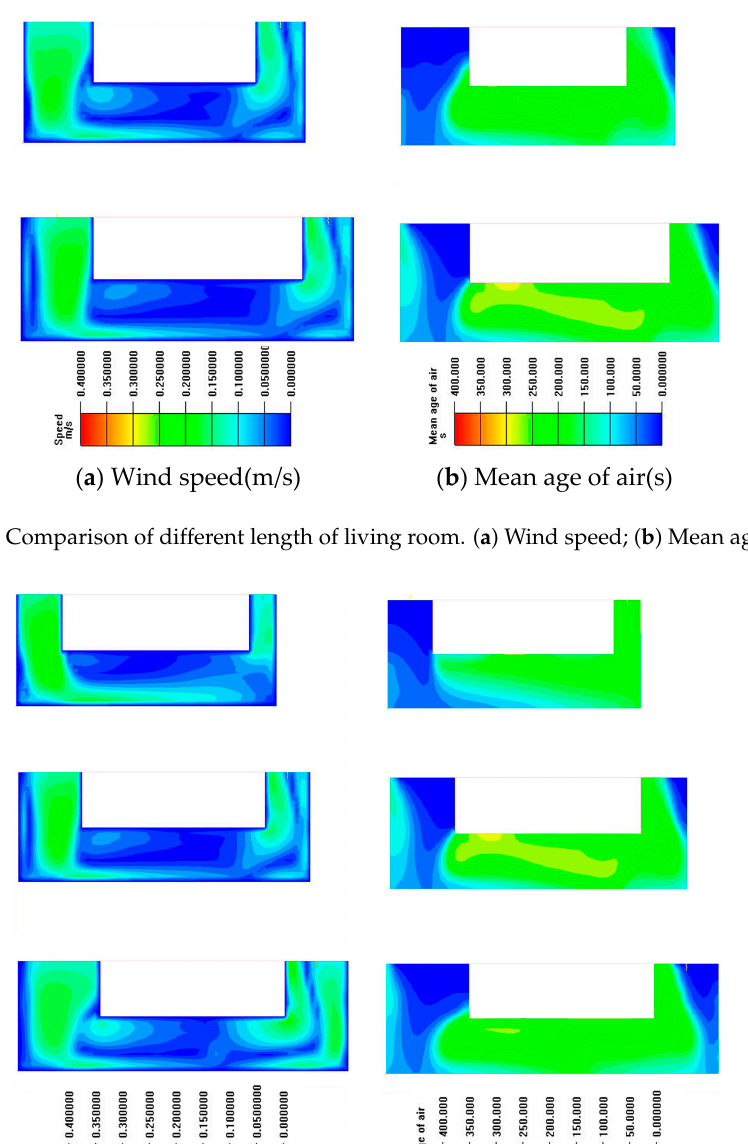
Figure 8. Comparison of different length of patio. ( a ) Wind speed; ( b ) Mean age of air.